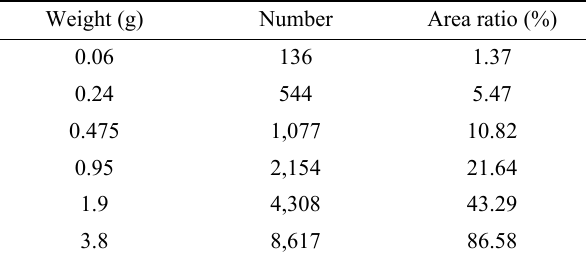
Table 1 The number of sand particles and area ratio at different weight of